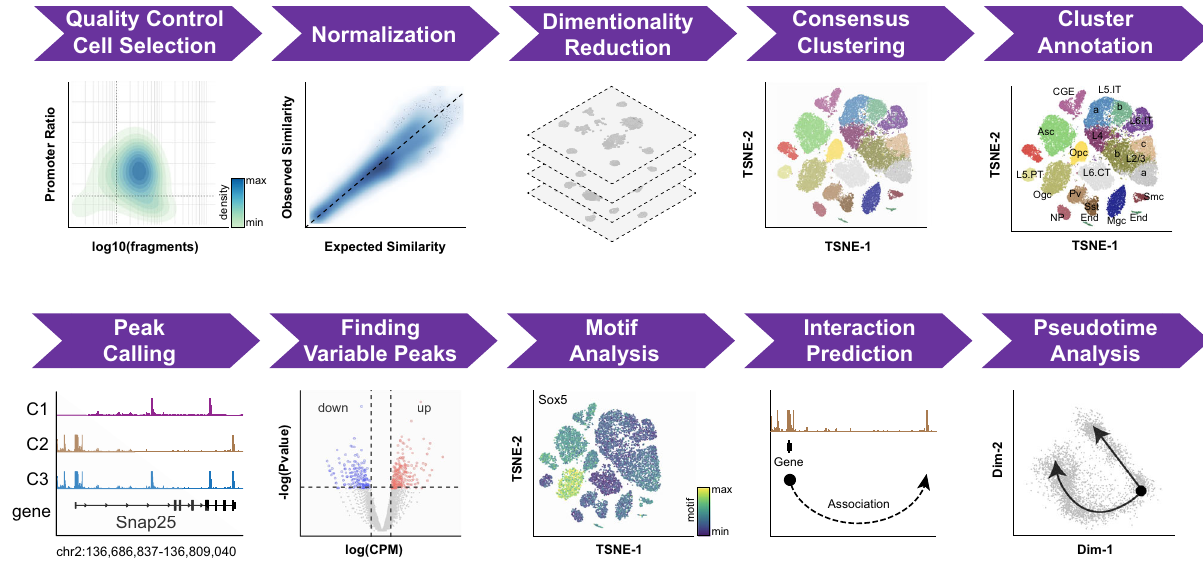
Fig. 1 Schematic overview of SnapATAC analysis work fl ow. See Methods section for details of each